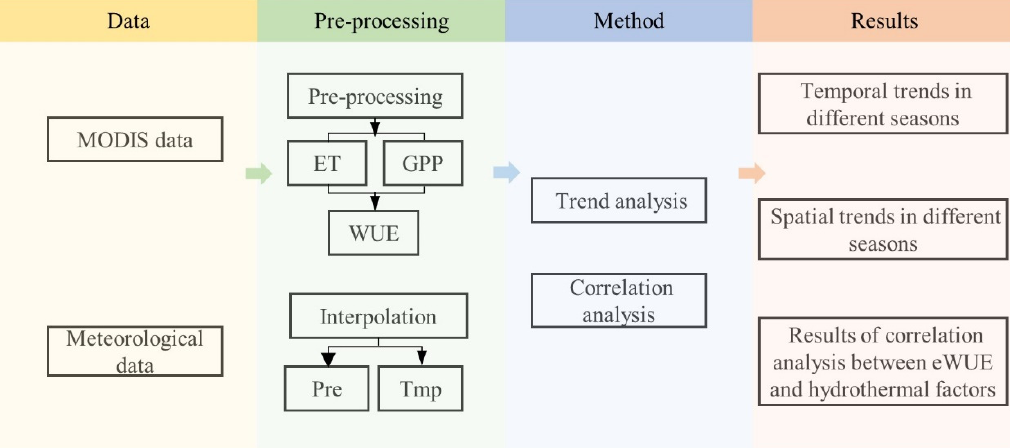
Figure 3. Flowchart of the study. Pre: Precipitation; Tmp: Temperature.